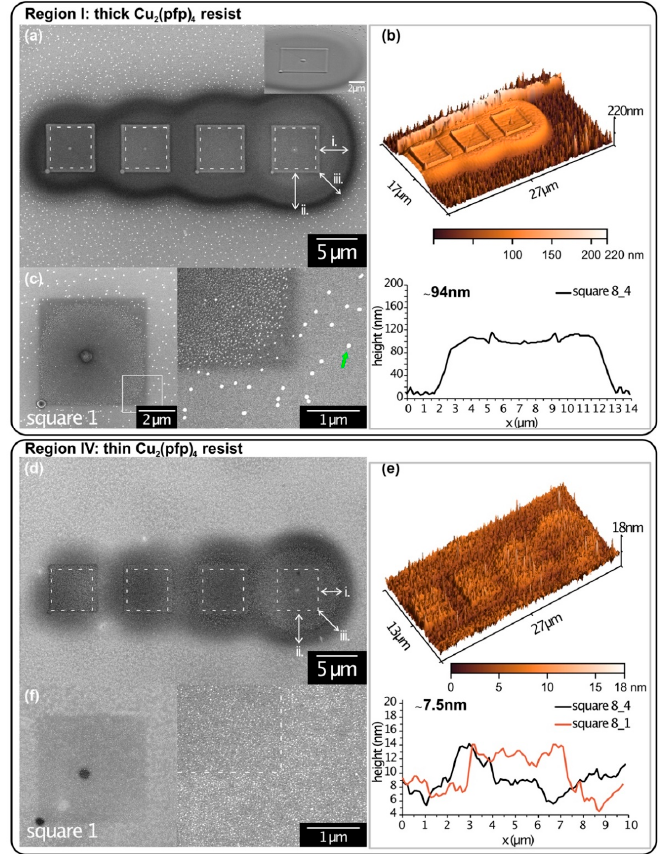
Figure 3. D-EBL structures from Cu 2 (pfp) 4 on a SiO 2 (nat.)/Si substrate after development via thermal resist evaporation in HV (substrate heated to T S = 190 ◦ C). ( a ) SEM image of the structures irradiated in the thick resist area (I). Halo radii are indicated. The inset shows a tilted view of square 8_4. The green arrow indicates a crystallite in the non-irradiated region. ( b ) 3D AFM image and height profile of these structures. ( c ) SEM images of square 1 (c.f. Supplementary Materials S2) with a high magnification image of the lower-left corner. ( d – f ) Results of the same structures in the thinnest region of the condensate